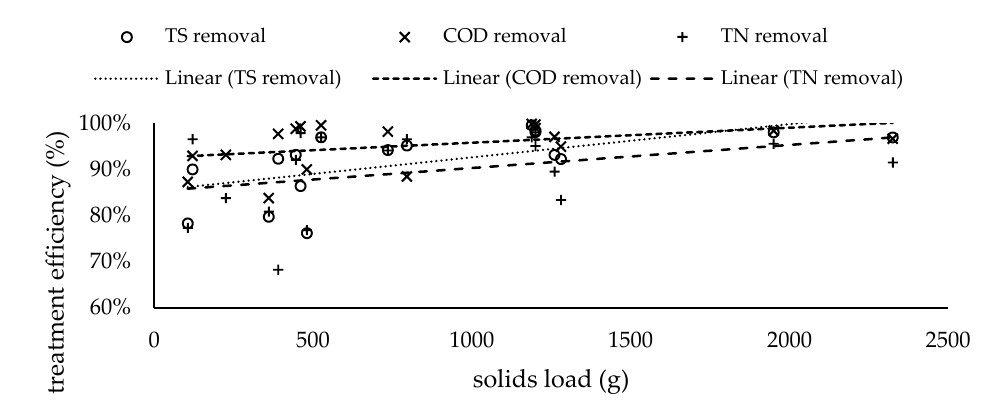
Figure 3. Influence of solids load on the removal of total solids (TS), chemical oxygen demand (COD), and total nitrogen (TN). The treatment performance were improved with the increasing solids load.